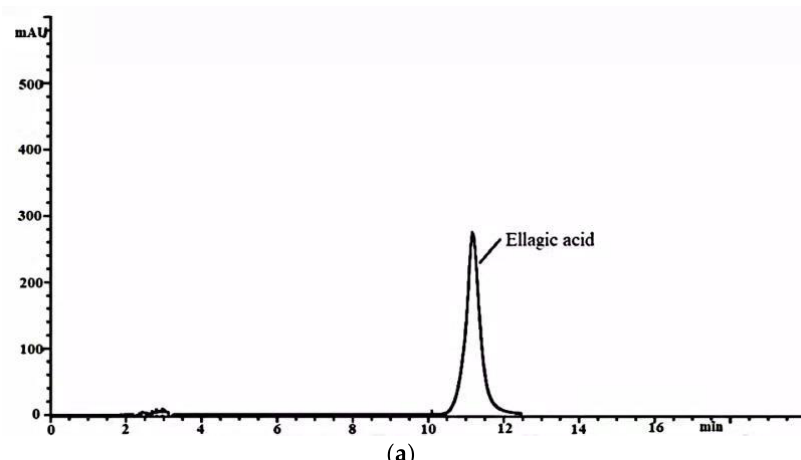
Figure 2. Response surface plots: ( a ) glucose dosage and fermentation time on the ellagic acid content, ( b ) glucose dosage and fermentation temperature on the ellagic acid content and ( c ) fermentation time and fermentation temperature on the ellagic acid